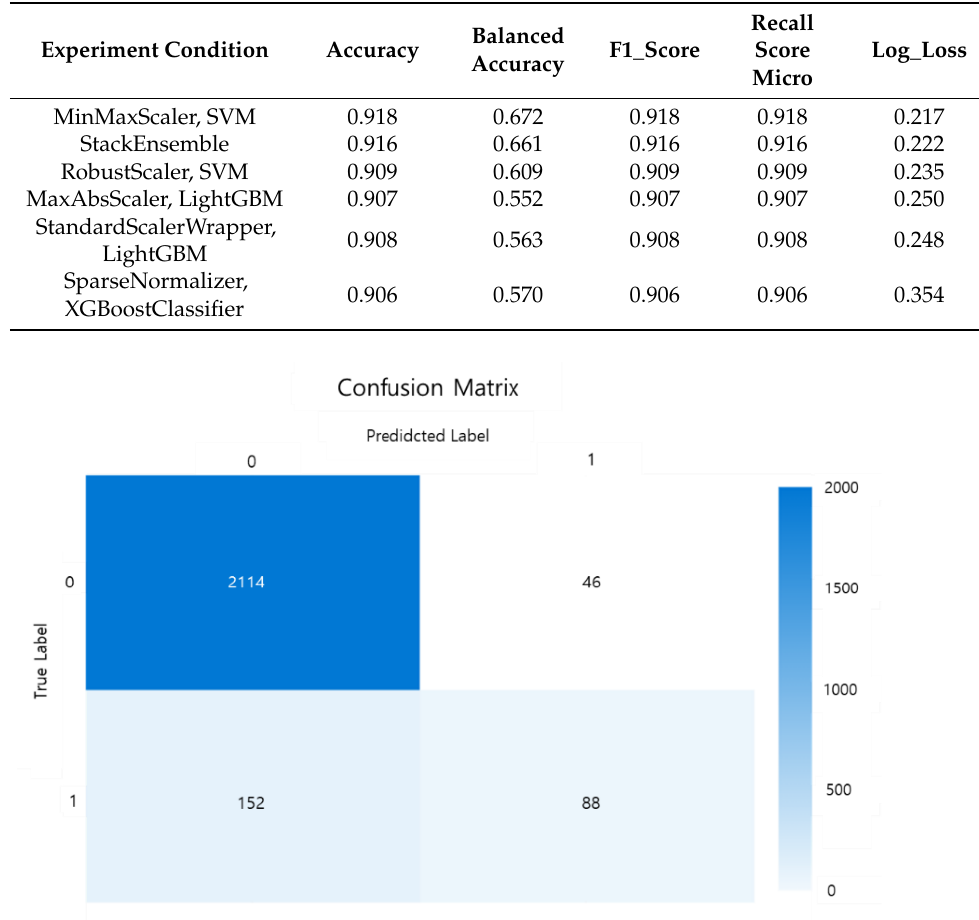
Figure 7. MinMaxScaler.SVM confusion matrix.